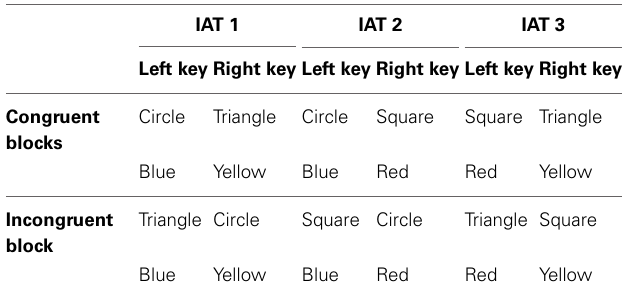
Table 2 | Order of blocks and response mappings for participants who did incongruent trials first (example from IAT 1). Table 3 | The response mappings in our 3 IAT